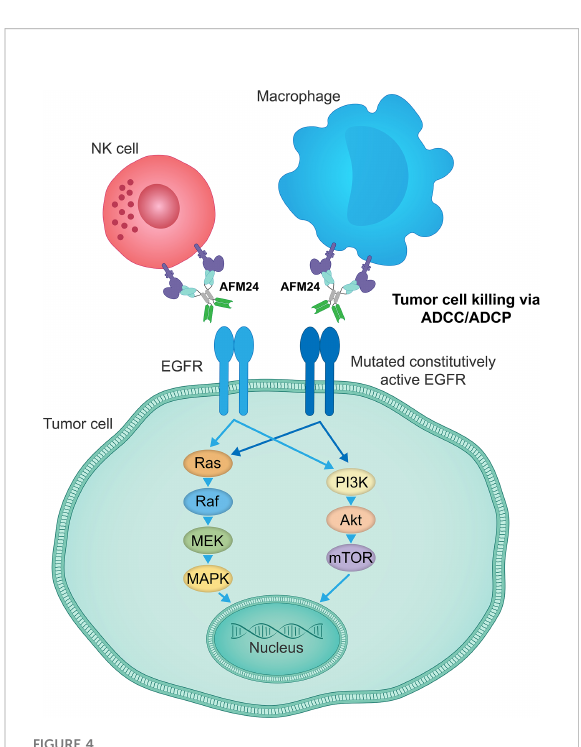
FIGURE 4 AFM24 activity is independent of EGFR signaling function. AFM24-mediated killing of EGFR-expressing tumor cells, by inducing ADCC and ADCP responses, does not rely on the EGFR activity, its mutational status or the disruption of downstream signaling pathways. ADCC, antibody-dependent cellular cytotoxicity; ADCP, antibody-dependent cellular phagocytosis; EGFR, epidermal growth factor